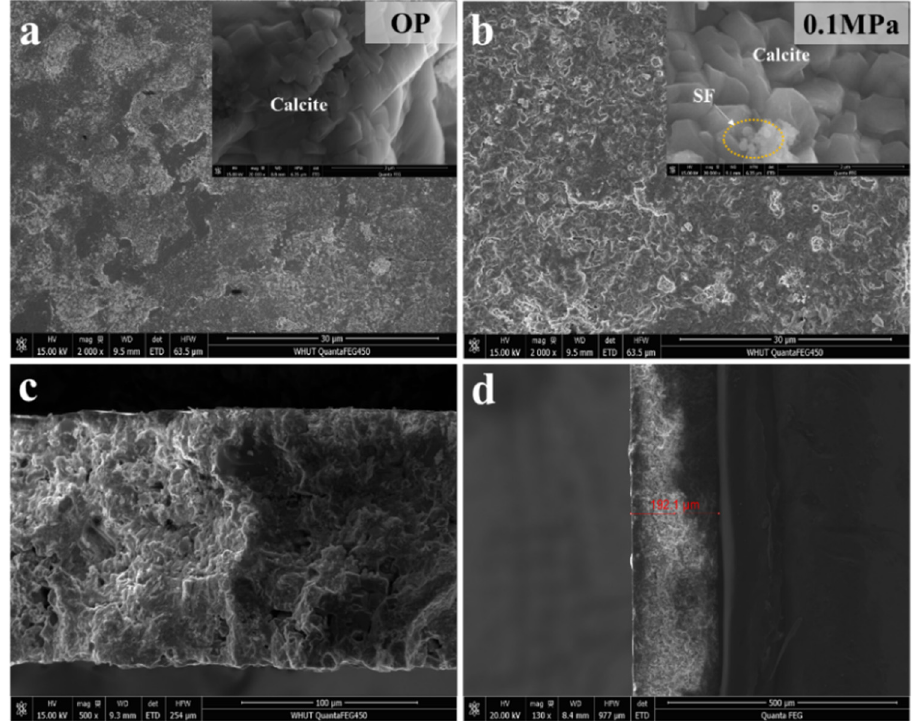
Figure 4. SEM images of the carbonated coatings. ( a , b ) the coatings after carbonation with different CO 2 pressures. ( c , d ) the cross section of the coatings (0.1 MPa) under different multiples.